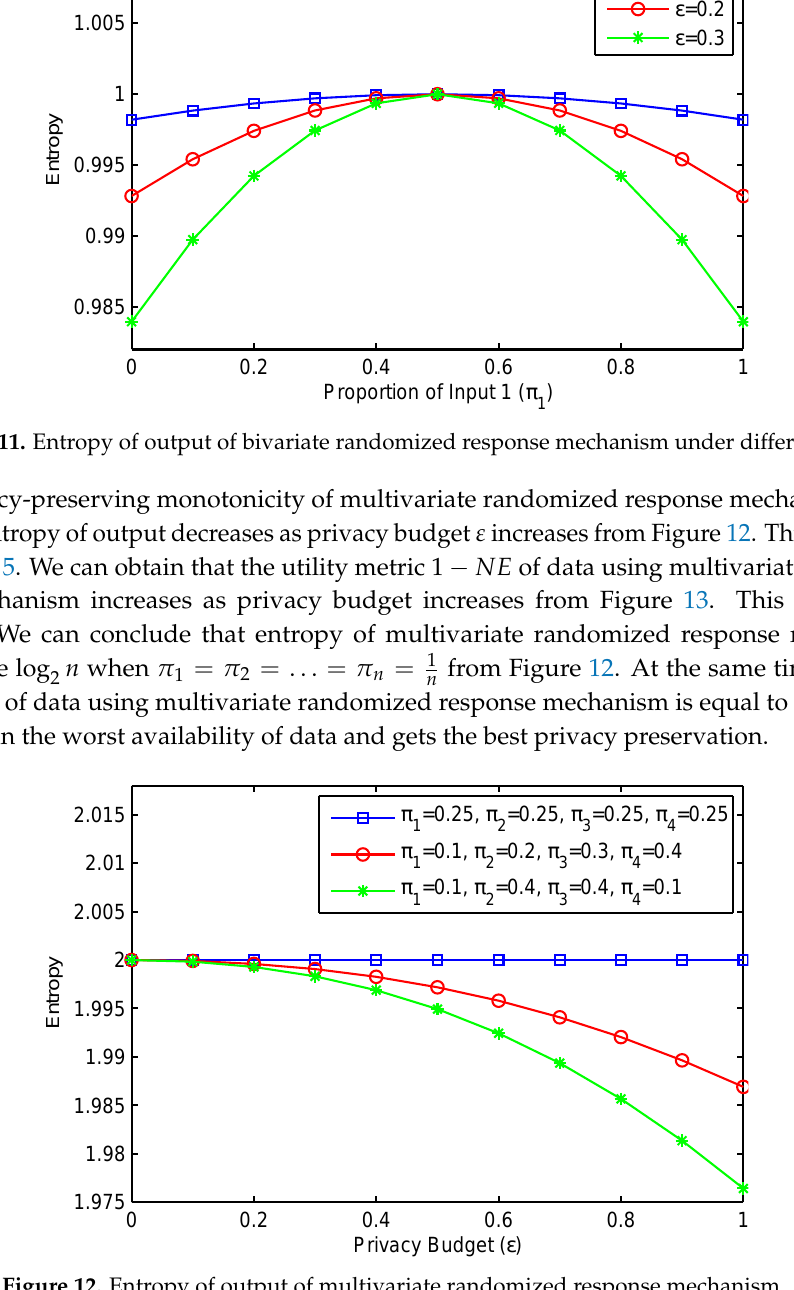
Figure 12. Entropy of output of multivariate randomized response